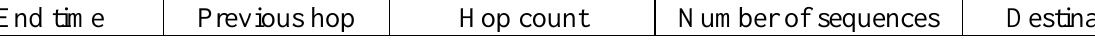
AODV protocol structure